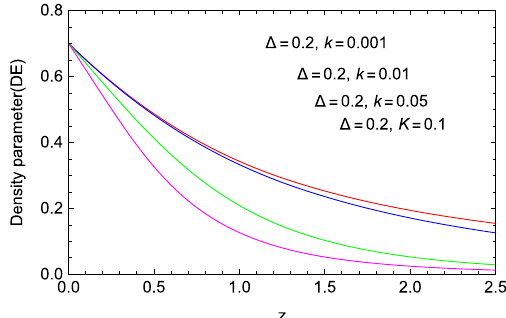
Fig. 1 Evolution of Barrow holographic dark energy density param- eter, as a function of redshift z , for Δ = 0 . 2 and C = 3 , in unit of M 2 p = 1. The line corresponds: red: k = 0 . 001 ; blue: k = 0 . 01 ; green: k = 0 . 05 ; magenta: k = 0 . 1